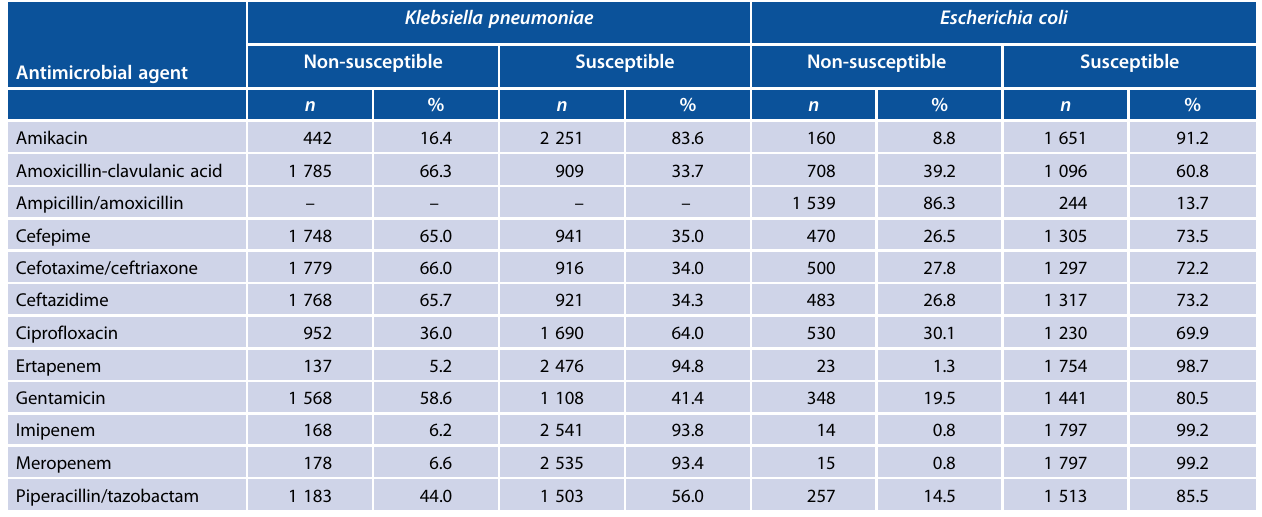
Table 3: Antimicrobial susceptibility patterns of Enterobacteriaceae isolated from blood cultures reported from 16 sentinel hospitals across South Africa, January 1, 2016 to December 31, 2016